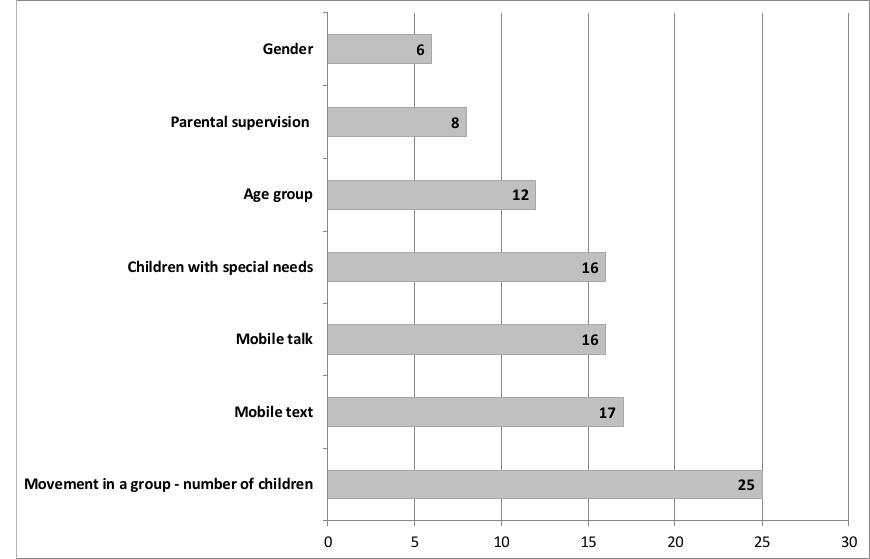
Figure 5. The influence of each model input parameter on the prediction results (%).